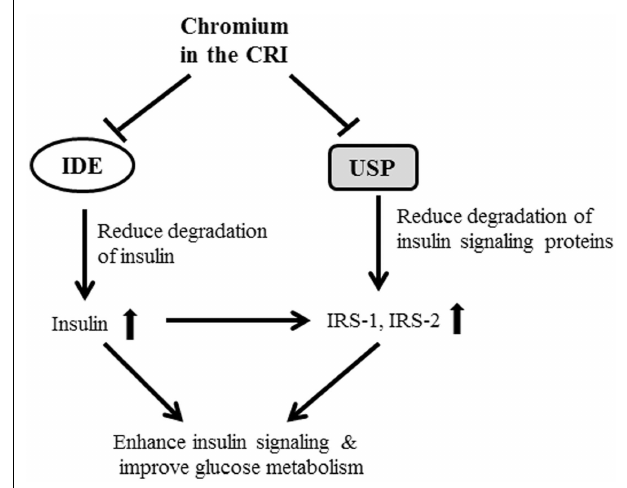
FIGURE 5 |The possible mechanisms of CRI enhancing insulin action and insulin signaling were shown in figure .The CRI treatment may directly suppress IDE and ubiquitin-proteasome system (UPS) in the liver, and result in reduction of insulin clearance and degradation of proteins (such as IRS-1 and IRS-2) in the downstream of insulin signaling pathway. The consequent of CRI treatment enhances insulin signaling, increases insulin sensitivity, and improves glucose metabolism in insulin-resistant and diabetic